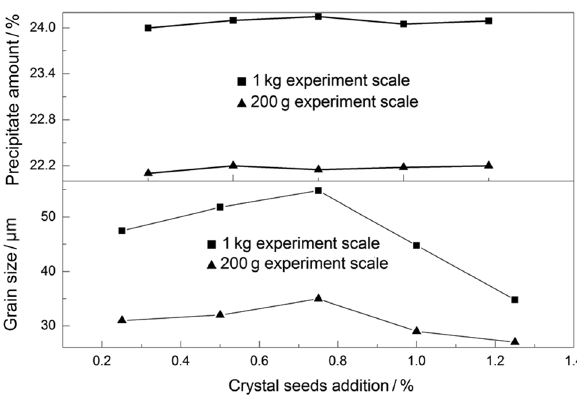
Figure 14: Precipitate amount and average grain size of rutile versus addition amount of crystal